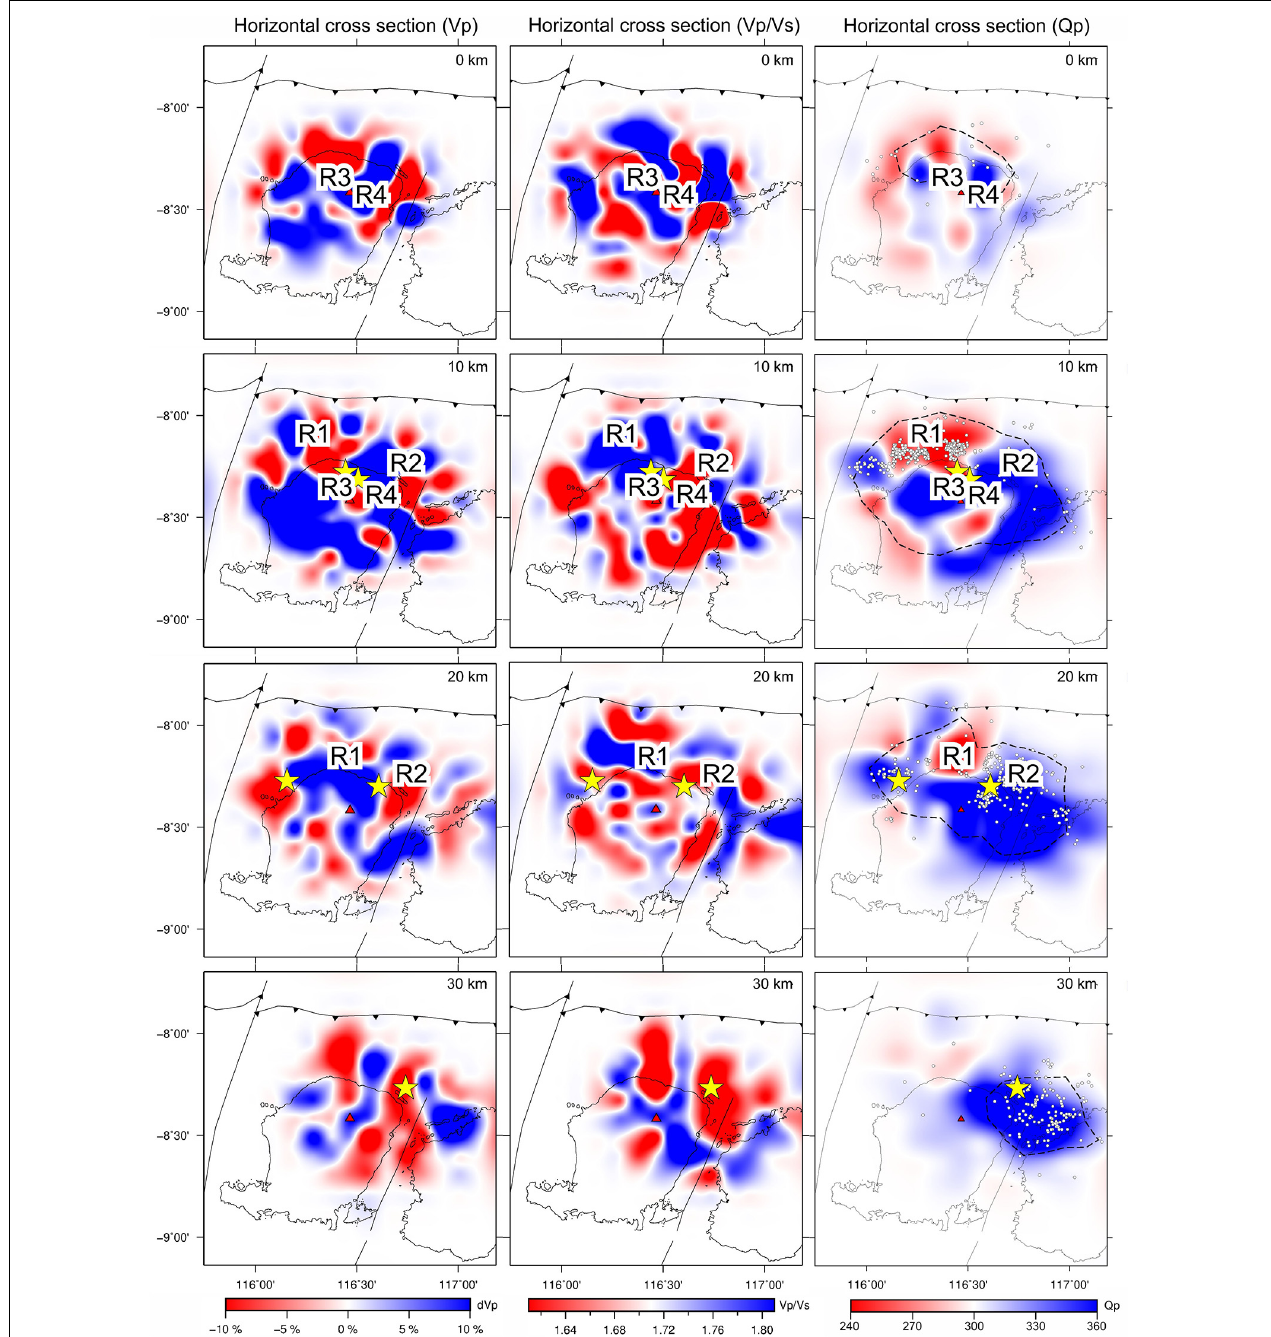
FIGURE 7 | Depth slices showing seismic velocity structure V p (first column) and V p / V s ratio (middle column) from Afif et al. (2020), and Q p (right column) at depth of 0, 10, 20, and 30 km. The color bar shows the variations in V p , V p / V s , and Q p . The V p are plotted as percent perturbations relative to the 1D initial velocity model, and V p / V s are plotted as an absolute value. Blue and red colors represent higher and lower values. The black dashed line in the Q p tomogram indicates well-resolved areas based on DRE ( > 0.1). The yellow stars represent the hypocenters of the significant event; white dots indicate aftershock hypocenters; the red triangle is the Rinjani volcano. The captions listing R1, R2, R3, and R4 are the regions interpreted in this